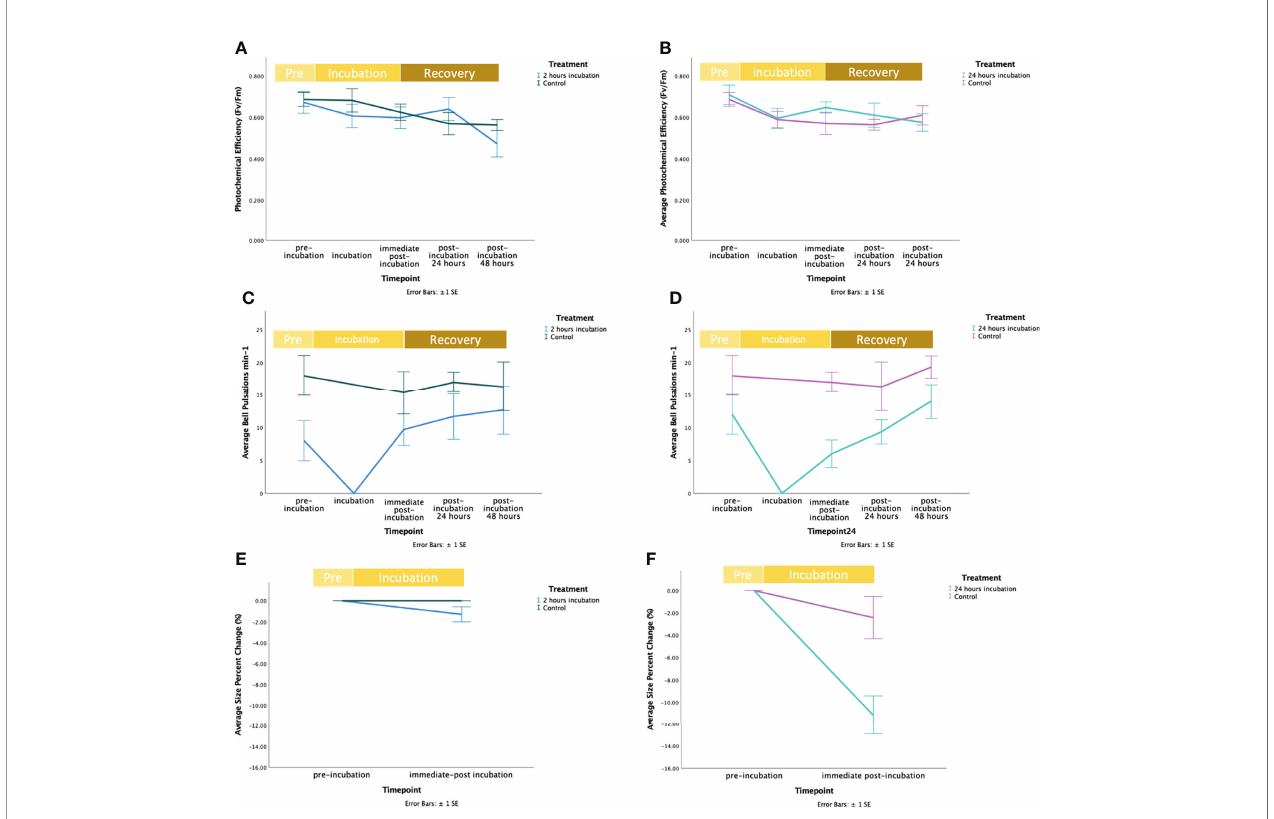
FIGURE 1 | Fluctuation of response variables during the exposure of Cassiopea sp. jelly fi sh to Magnesium Chloride (MgCl 2 ), including the recovery time. In fi gures a, c, and e the blue line represents the control, and the green line represents the treatment. In fi gures b, d, and f the purple line represents the control, and the mint line represents the treatment. (A) Fluctuations of average photochemical ef fi ciency ( Fv/Fm ) at the start ( “ pre-incubation ” ), middle ( “ incubation ” ) and end ( “ immediate post- incubation ” ) of the 2 hours exposure to MgCl 2 and during the recovery period ( i.e. , “ post-incubation 24 hours ” and “ post-incubation 48 hours ” indicates the recovery period of 24 and 48 hours after the end of the exposure to MgCl 2 ). Bars represent standard error (± SE). (B) Fluctuations of average photochemical ef fi ciency ( Fv/Fm ) at the start ( “ pre-incubation ” ), middle ( “ incubation ” ) and end ( “ immediate post-incubation ” ) of the 24-hour exposure to MgCl 2 and during recovery period ( i.e. , “ post- incubation 24 hours ” and “ post-incubation 48 hours ” after the end of the exposure to MgCl 2 ). Bars represent standard error (± SE). (C) Fluctuations of the average number of bell pulsations min -1 at the start ( “ pre-incubation ” ), middle ( “ incubation ” ) and end ( “ immediate post-incubation ” ) of the 2-hour exposure to MgCl 2 and during the recovery period ( i.e. , “ post-incubation 24 hours ” and “ post-incubation 48 hours ” indicates the recovery period of 24 and 48 hours after the end of the exposure to MgCl 2 ). Bars represent standard error (± 1SE). (D) Fluctuations of the average number of bell pulsations min -1 at the start ( “ pre-incubation ” ) and end ( “ immediate post-incubation ” ) of the 24-hour exposure to MgCl 2 and during the recovery period ( i.e. , “ post-incubation 24 hours ” and “ post-incubation 48 hours ” indicates the recovery period of 24 and 48 hours after the end of the exposure to MgCl 2 ). Bars represent standard error (± SE). (E) Fluctuations of the average size percent change (%) at the start ( “